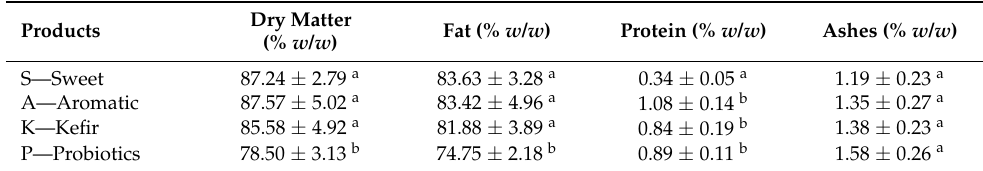
Table 1. Chemical composition of sheep’s butters produced with sweet cream and with cream fermented with different starter cultures. Different superscript lowercase letters in each column (a,b) indicate significant differences ( p < 0.05) between